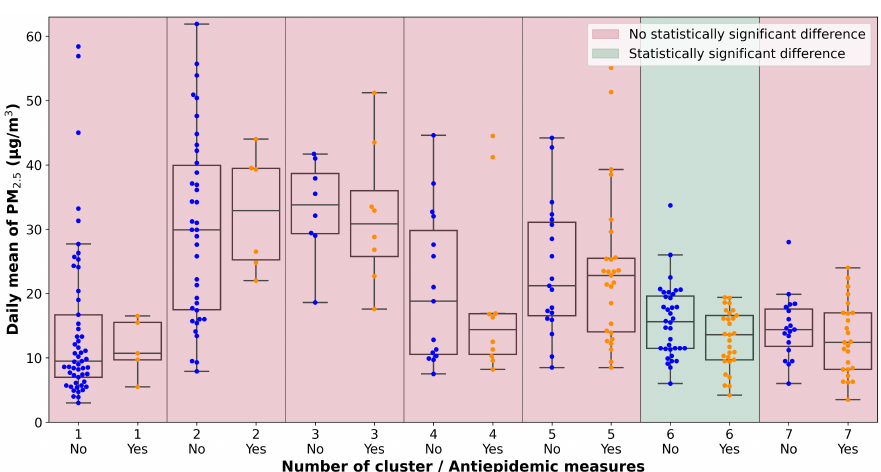
Figure 9. Results of the ANOVA test, Ostrava-Pˇrívoz, NO x .